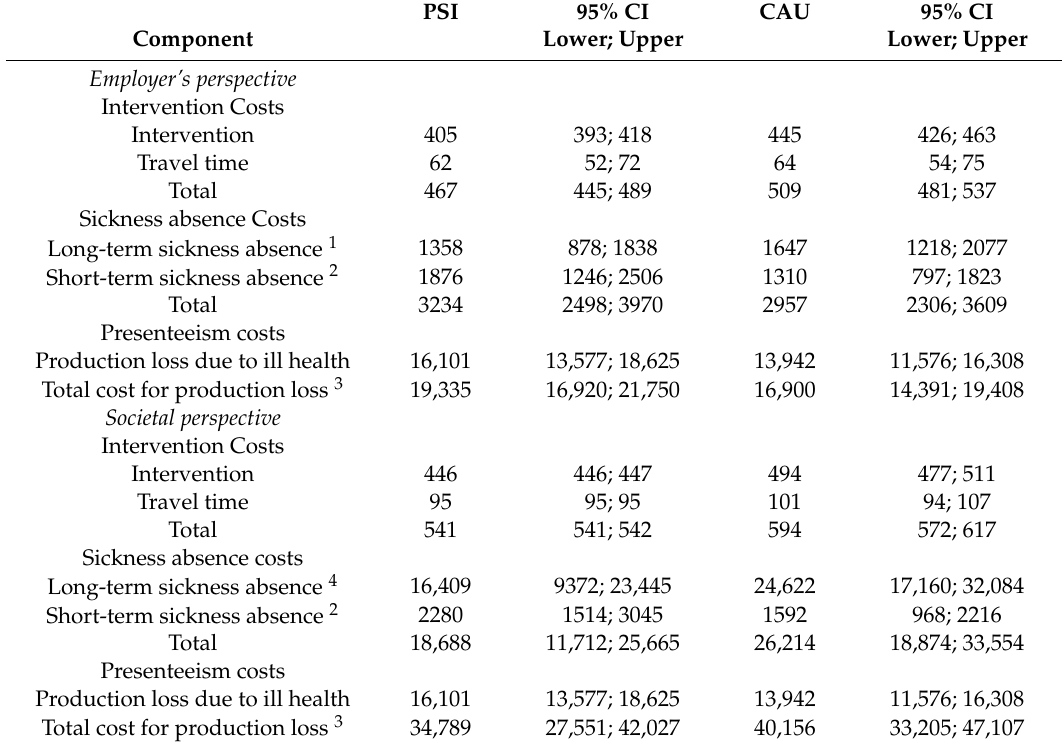
Table 4. Total and Mean Component Costs (EURO / Employee) for PSI and CAU from an Employer and a Societal Perspective.